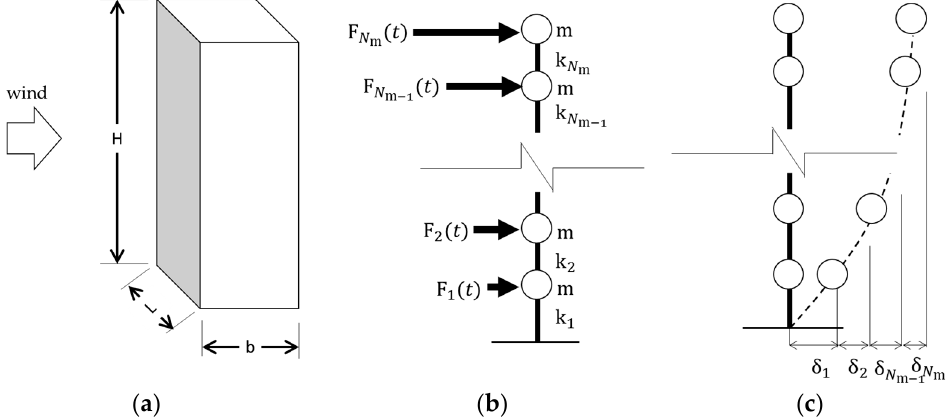
Figure 4. ( a ) Prismatic buildings with rectangular cross section; ( b ) multi-degree-of-freedom structure; ( c ) story drift.